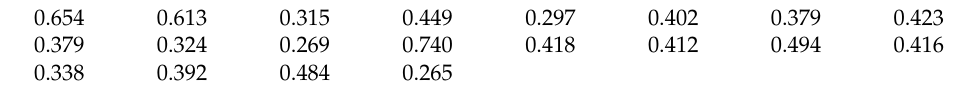
Table 6. Flood level data.